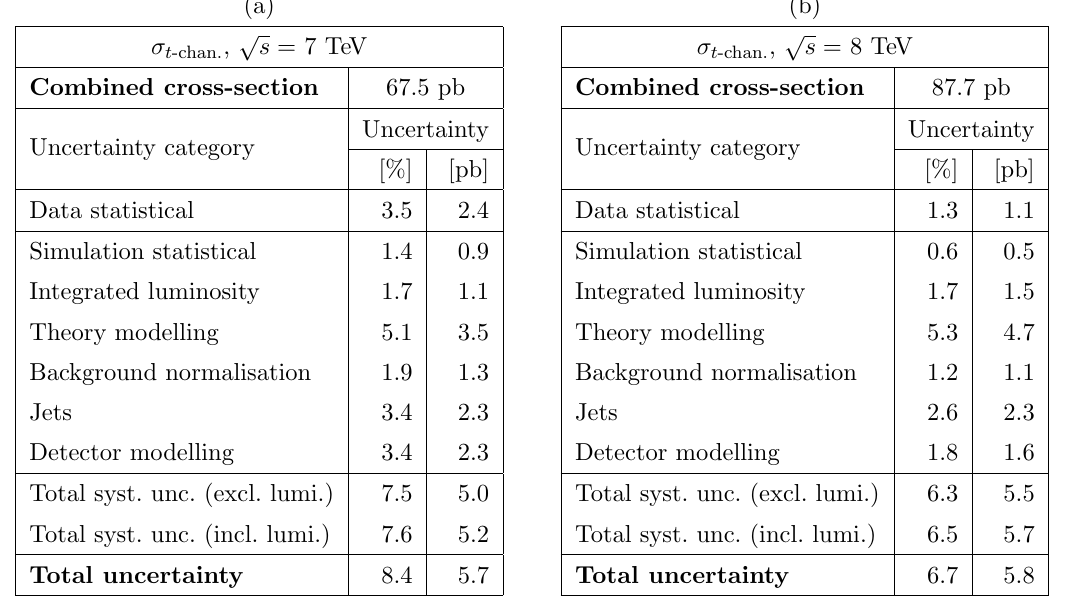
Table 3 . Contribution from each uncertainty category to the combined t -channel cross-section ( (cid:27) t -chan. ) uncertainty at (a) p s = 7 TeV and (b) p s = 8 TeV. The total uncertainty is computed by adding in quadrature all the individual systematic uncertainties (including the uncertainty in the integrated luminosity) and the statistical uncertainty in data. Correlations of systematic un- certainties between experiments are presented in appendix